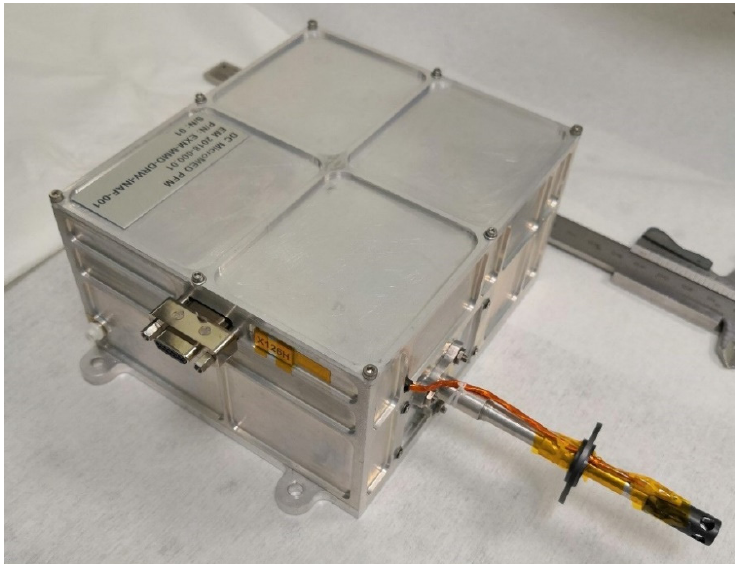
Figure 1. MicroMED’s proto Flight Model .